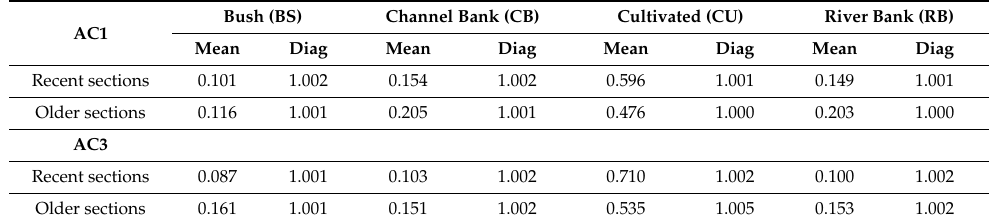
Table A5. The mean values and Gelman diagnostics (Diag.) of the Bayesian Mixing model output of cores AC1 and AC3, specified for recent and older core